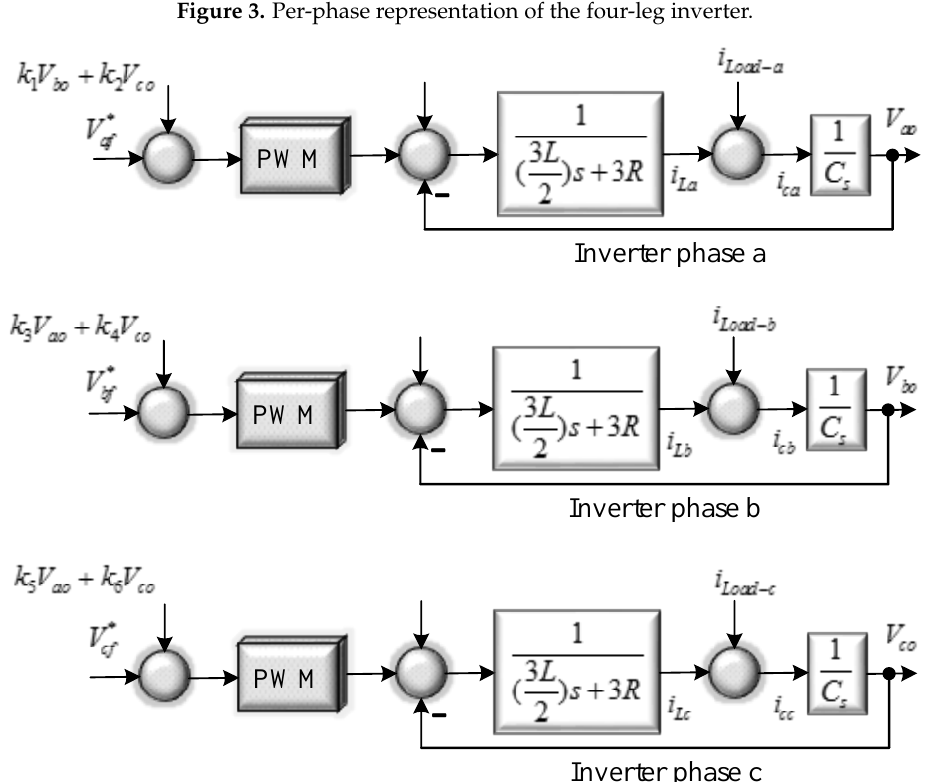
Figure 4. Decoupled model of the four-leg pulse width modulation inverter.